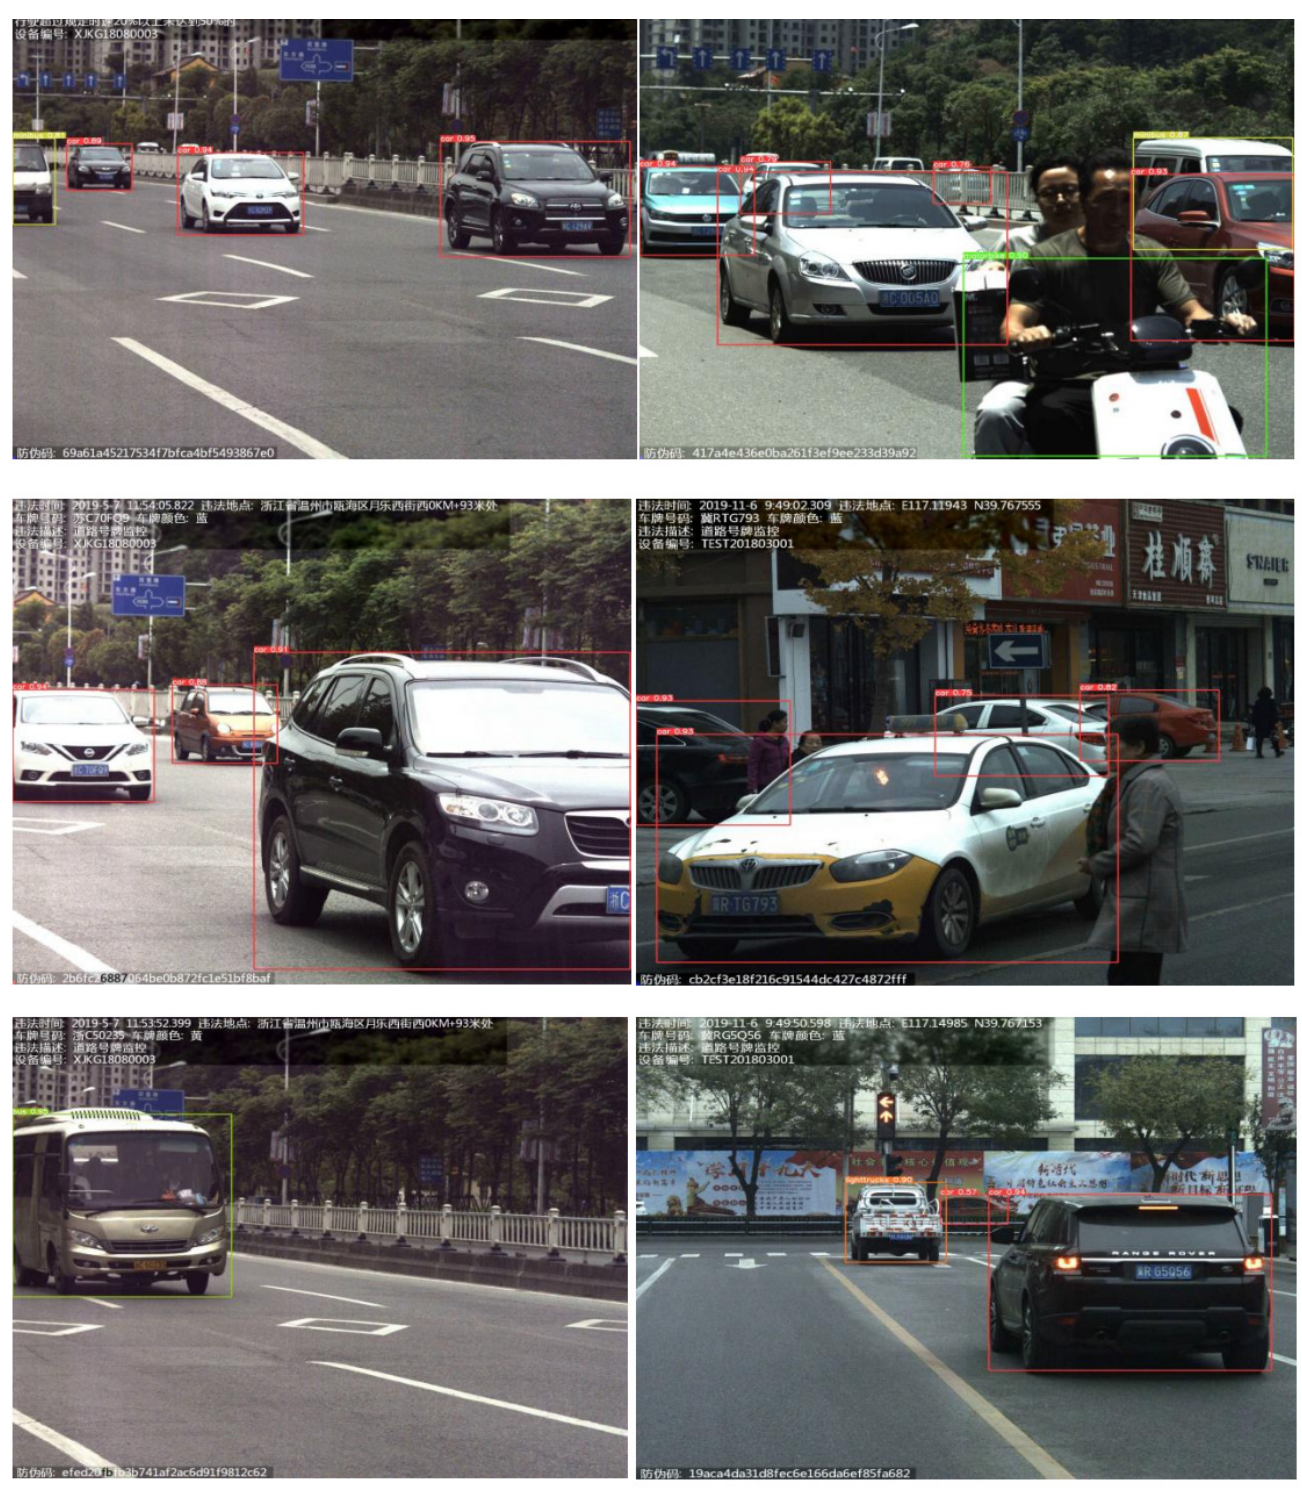
Figure 8. Results on the VOC2019 dataset.